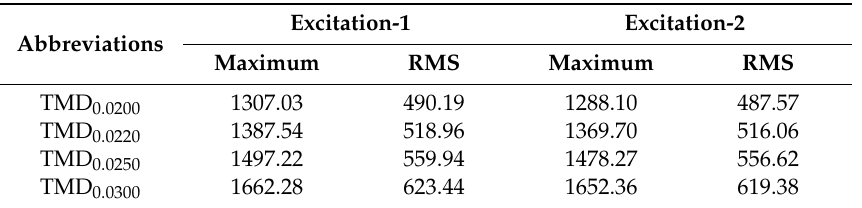
Table 3. The TMD damping forces.